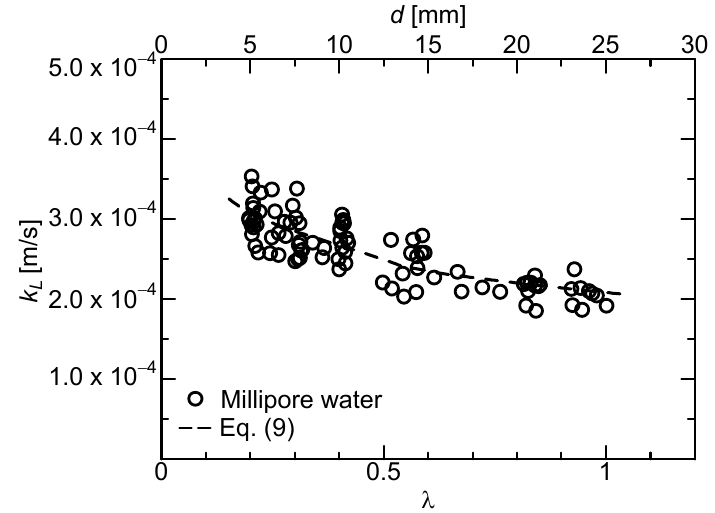
Fig. 4 Mass transfer coefficient of a bubble in stagnant Millipore